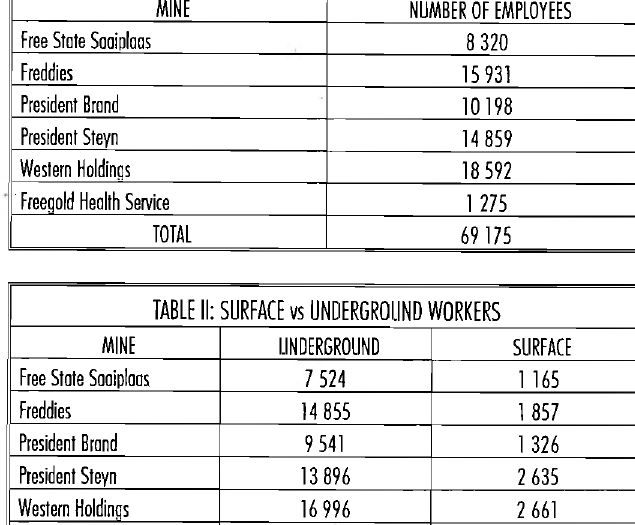
TABLE II: SURFACE vs UNDERGROUND WORKERS